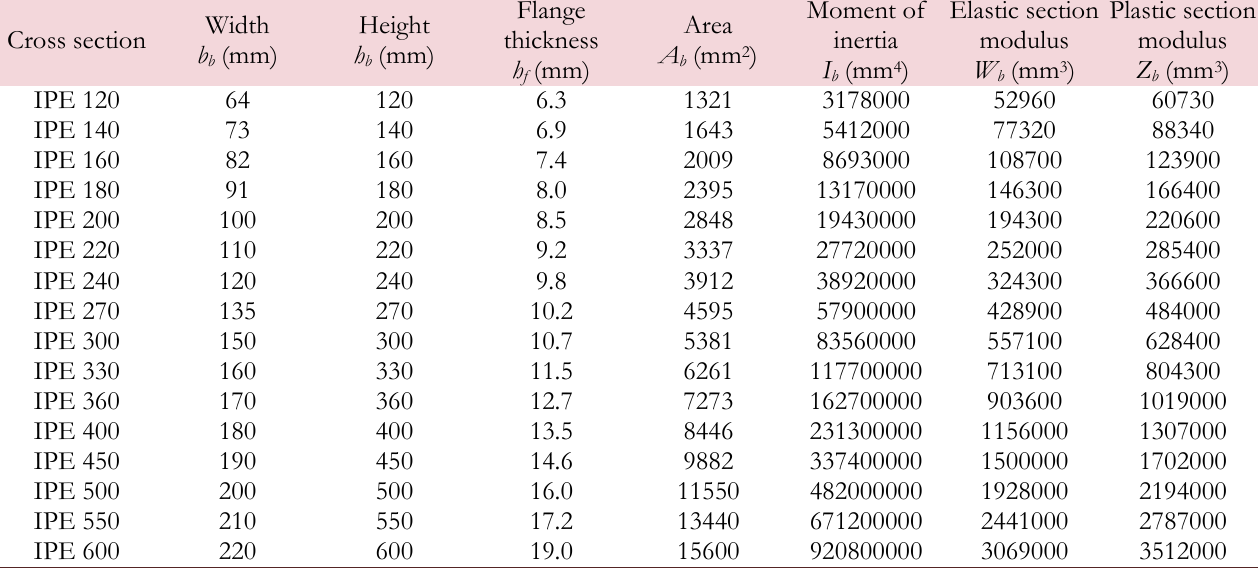
Table 1: Geometric properties of steel cross